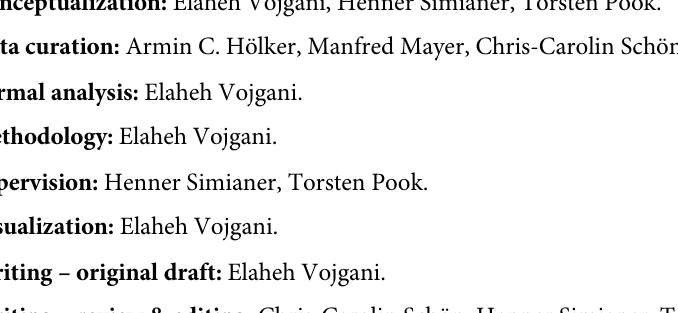
stars indicate which proportion of interactions in bivariate sERRBLUP maximized the predic- tive ability based on pruned set of SNPs in each environment for KE and PE, respectively. S18 Table. Genomic correlation between 2017 and 2018 in each environment for trait PH_final for KE (blue numbers) and PE (red numbers). The blue and red bold numbers with stars indicate which proportion of interactions in bivariate sERRBLUP maximized the predictive ability based on pruned set of SNPs in each environment for KE and PE, respec- tively. S19 Table. Genomic correlation between 2017 and 2018 in each environment for trait FF for KE (blue numbers) and PE (red numbers). The blue and red bold numbers with stars indicate which proportion of interactions in bivariate sERRBLUP maximized the predictive ability based on pruned set of SNPs in each environment for KE and PE, respectively. S20 Table. Genomic correlation between 2017 and 2018 in each environment for trait RL for KE (blue numbers) and PE (red numbers). The blue and red bold numbers with stars indicate which proportion of interactions in bivariate sERRBLUP maximized the predictive ability based on pruned set of SNPs in each environment for KE and PE, respectively. S21 Table. Phenotypic correlation between 2017 and 2018 in each environment for KE and